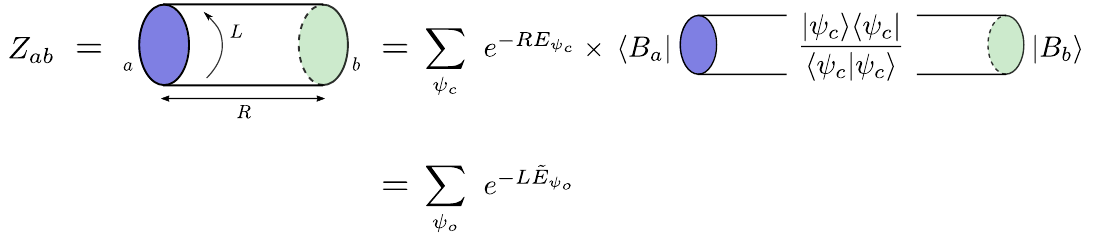
Figure 18 . The cylinder partition function and the g -function. The cylinder partition function can be expanded in two di(cid:11)erent channels: in the closed string channel, it is given in terms of overlaps between the boundary states and the closed string states and the propagation factor e (cid:0) RE c . In the open string channel, it is a standard thermal partition